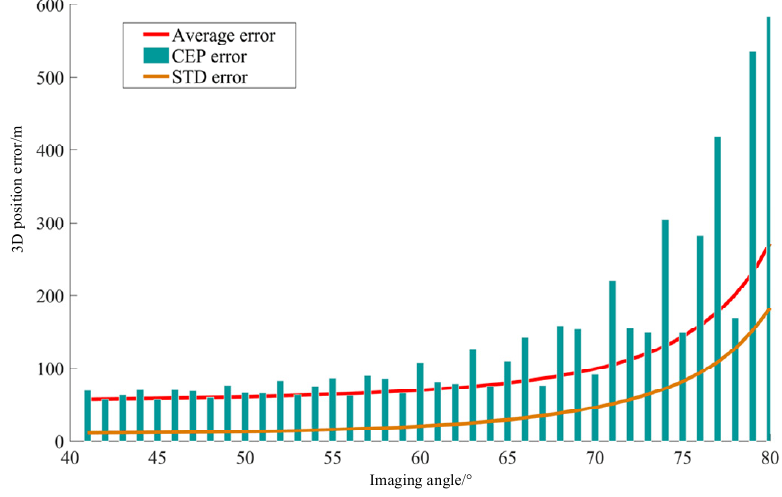
Figure 12. Comparison of evaluation standards.